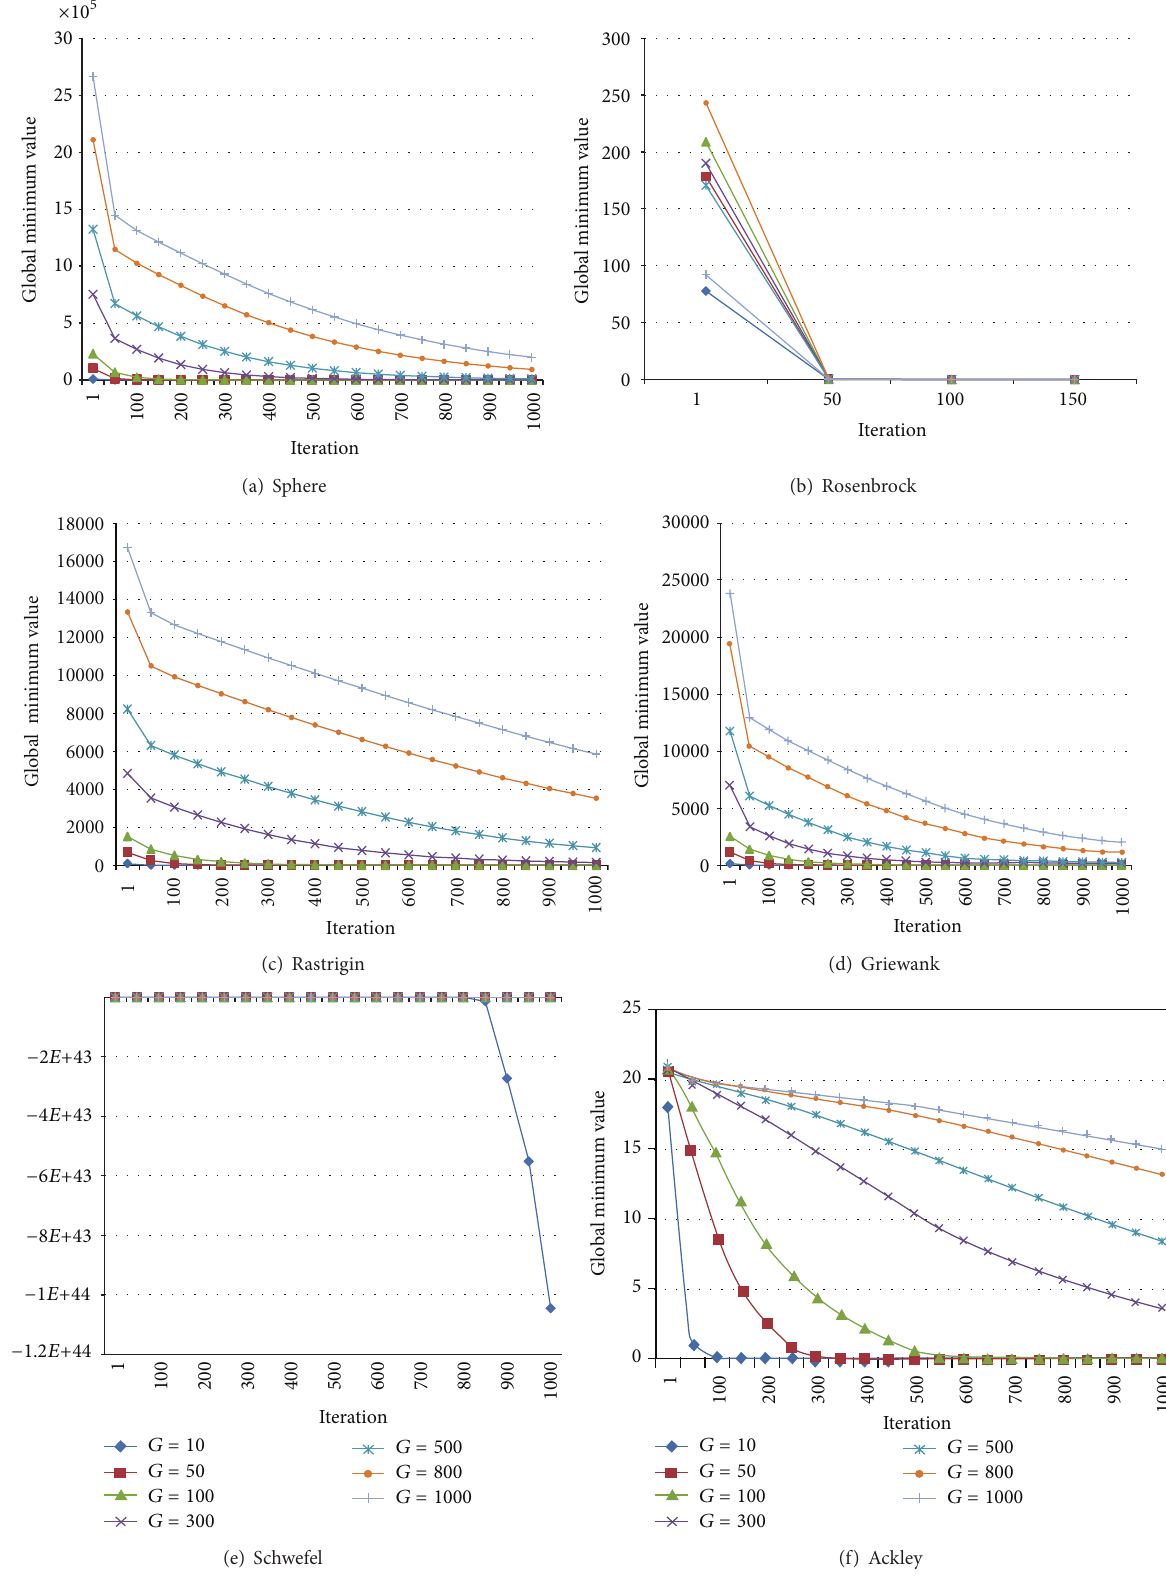
Figure 1: Mean global minimum convergence graphs of benchmark functions in 1000 generations for genotype sizes (𝐺) of 10, 50, 100, 300, 500, 800 and